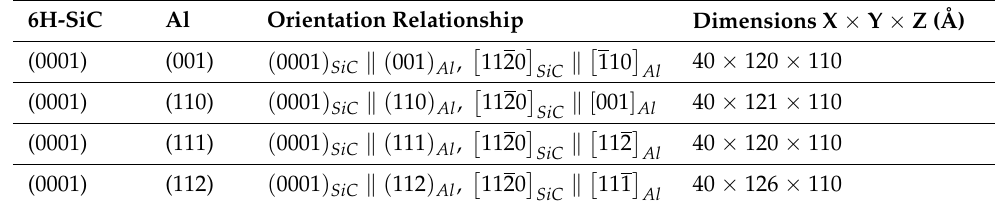
Table 2. Orientation relationships of the SiC/Al interface systems studied in this